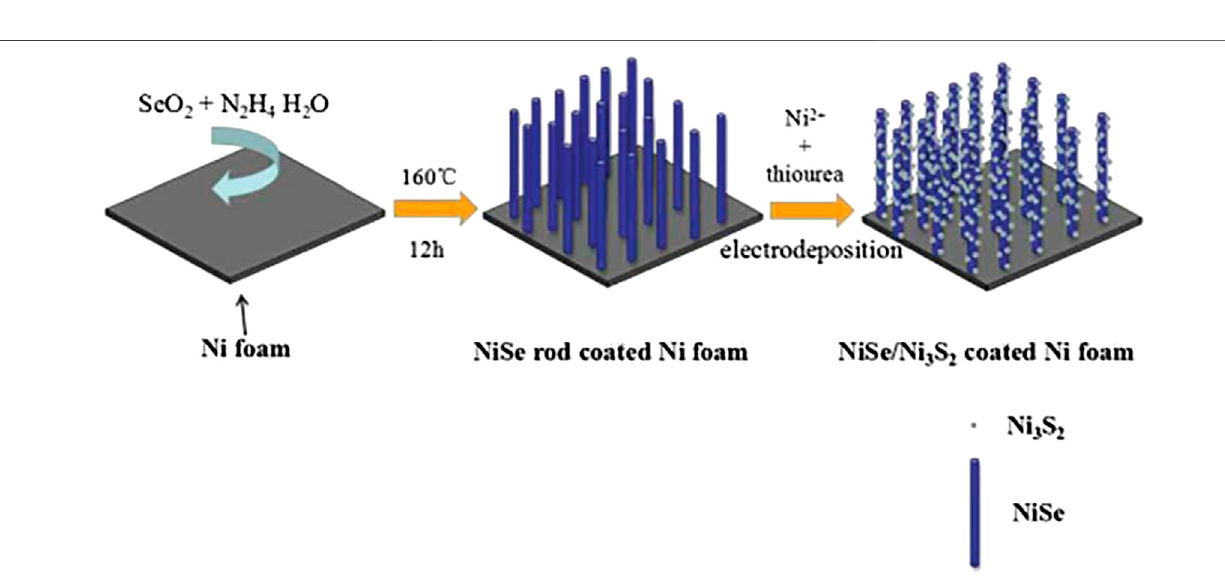
FIGURE 17 | Ni3S2-coated NiSe arrays as positive